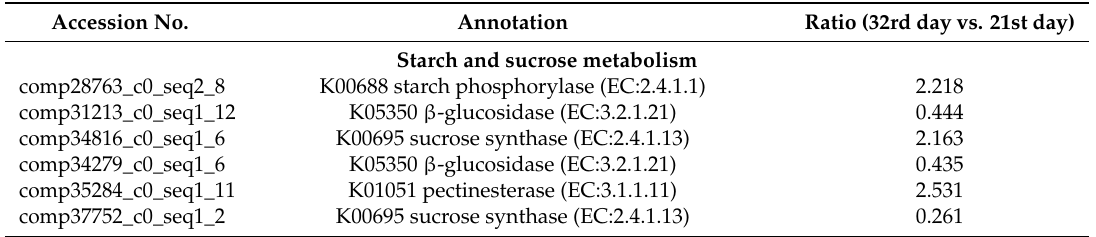
Table 2. Proteins enriched in several KEGG pathways with a positive correlation ( p -value < 0.05, FC (pro) > 1.5, FC (RNA) > 2) between the levels of transcripts and proteins. Accession